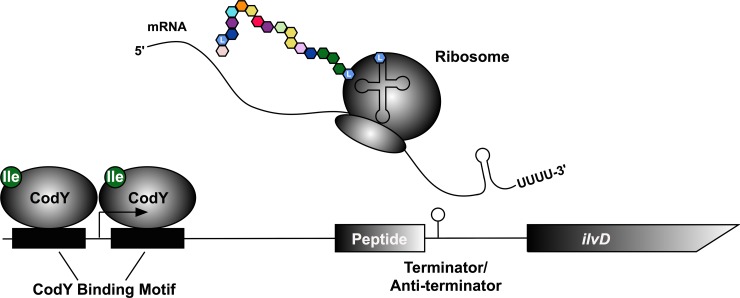
Model of mechanisms regulating ilv-leu expression.Transcription of the ilv-leu operon is repressed by CodY. In the presence of Ile, CodY binds and represses transcription. As Ile is depleted, CodY becomes inactive and expression of the operon is induced. As the operon is transcribed, the ribosome beings translating the open reading frame (ORF) upstream of ilvD. The ORF is rich in Ile and Leu and will stall if cells are depleted of either tRNA. Stalling of the ribosome prevents formation of the terminator hairpin, allowing transcription of the operon to proceed. When there is sufficient Ile/Leu tRNA, the ORF is translated and the terminator hairpin forms, terminating transcription.